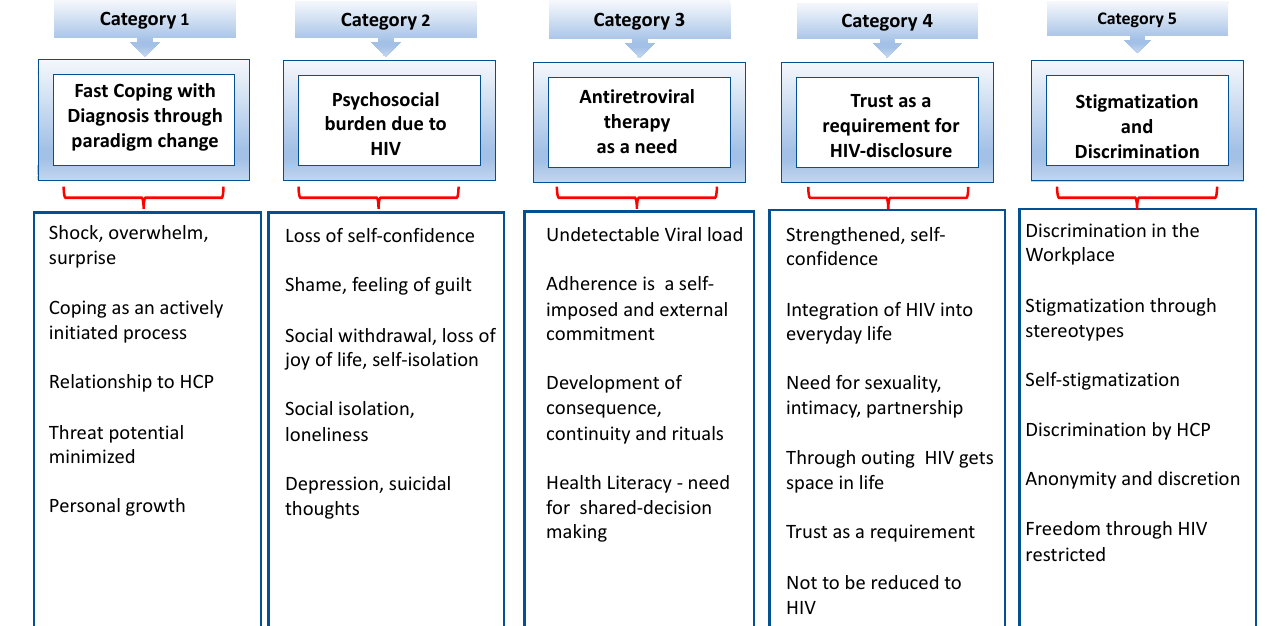
Figure 1. The five core categories (own presentation).